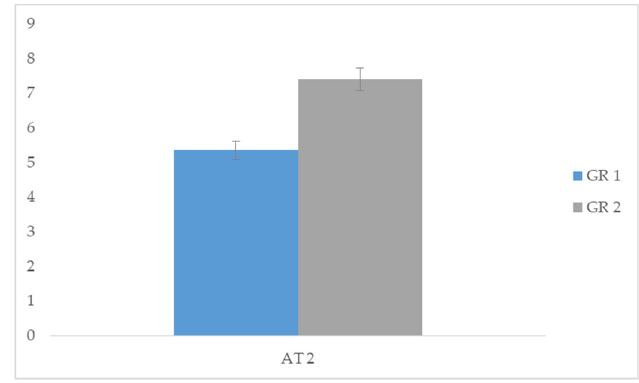
Figure 3. Comparison of AT2 task acquisition times between GR 1 and GR 2.